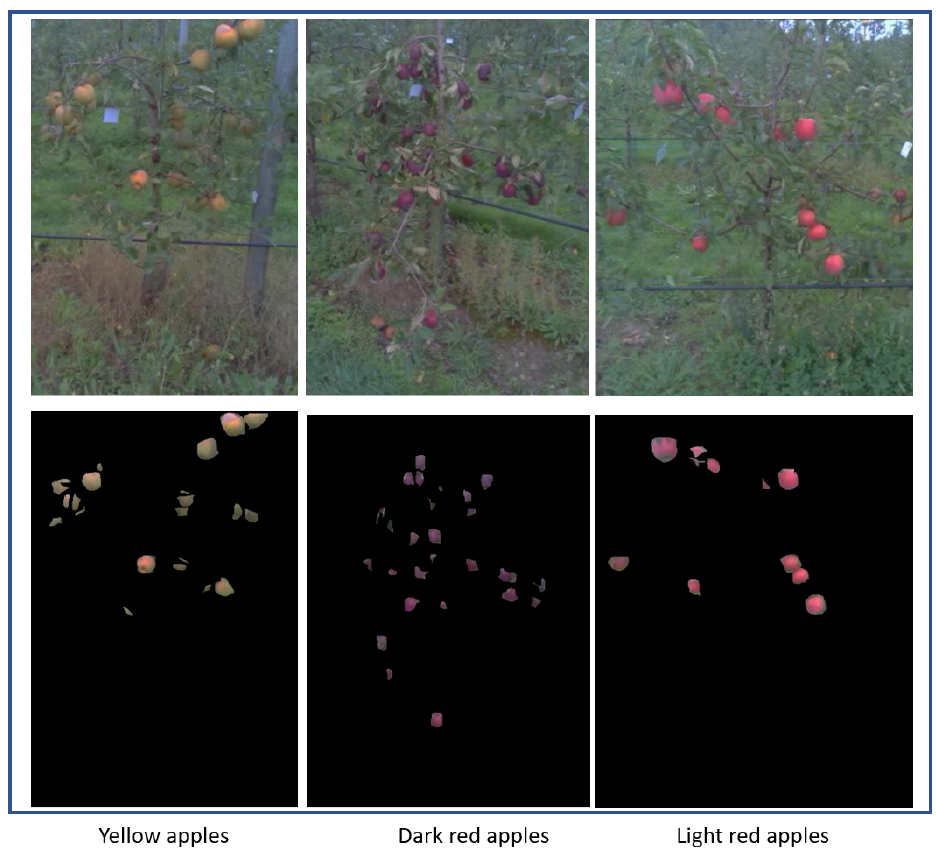
Figure 2. Example of RGB images of apple trees from our dataset and the corresponding ground-truth (manually